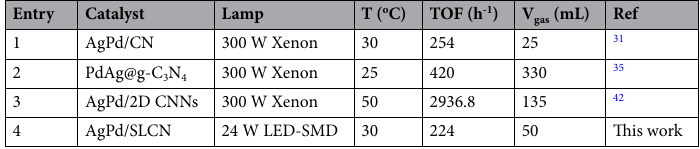
Table 1. Comparison of different AgPd/C 3 N 4 -based photocatalysts for H 2